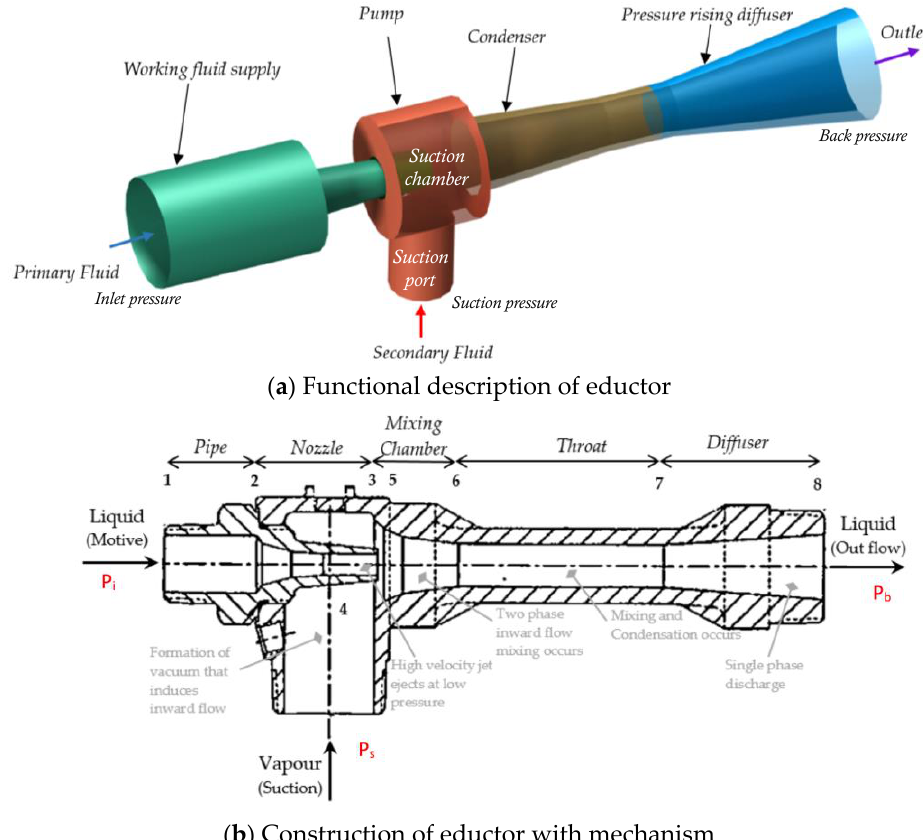
Figure 1. Components of an eductor and their function.